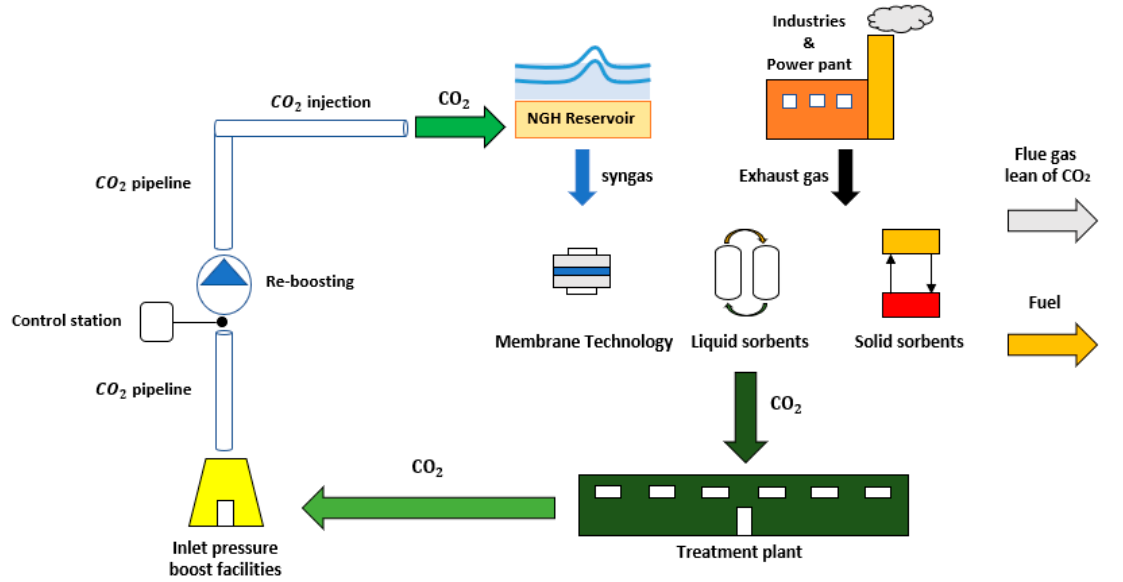
Figure 18. Final CCS chain. The flue gas from industries and power plants is treated into the separation unit. The CO 2 captured is transported via pipeline to the NGH reservoir. The injection of CO 2 causes a syngas production. The syngas was purified through membrane technology, and the permeant gas-rich of CO 2 will be injected another time in NGH reservoir. The fuel product rich of methane is in this way a neutral carbon fuel.